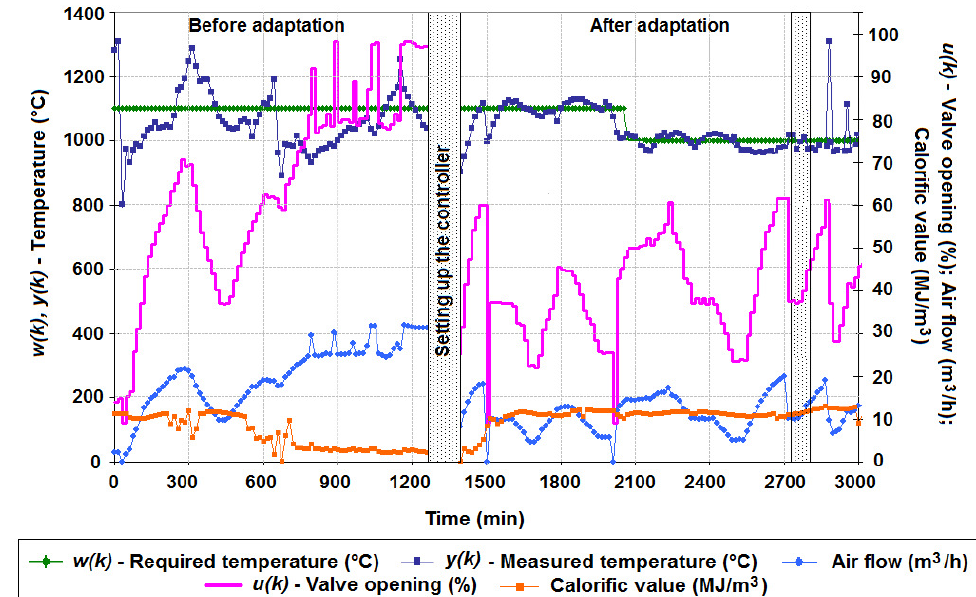
Figure 3. Temperature stabilization with controller adaptation